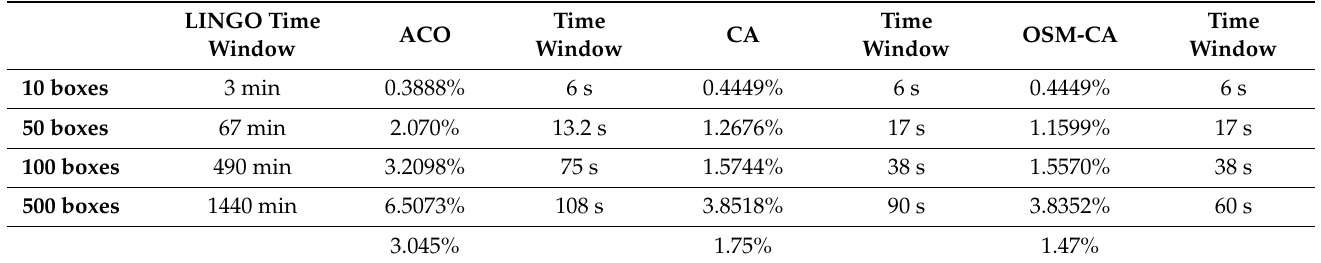
Table 18. The comparison among different groups for an unused area ft 2 .